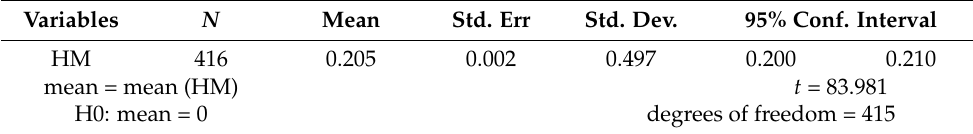
Table 3. Herding measures: results from the t